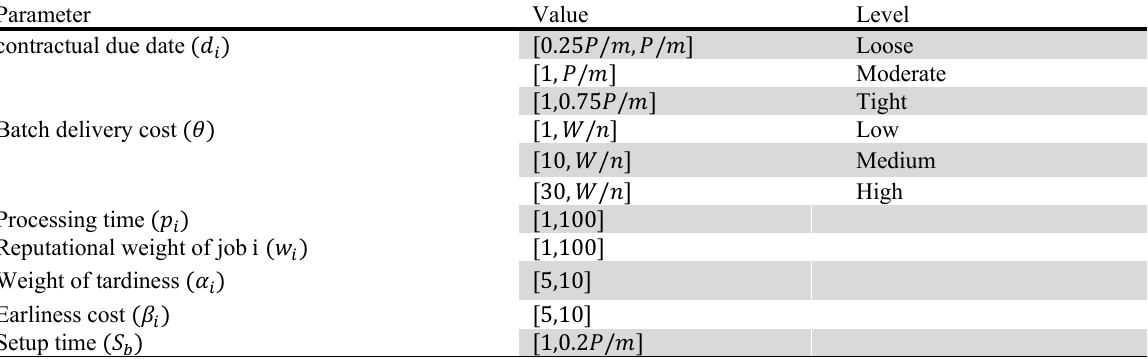
Parameters and their values Parameter